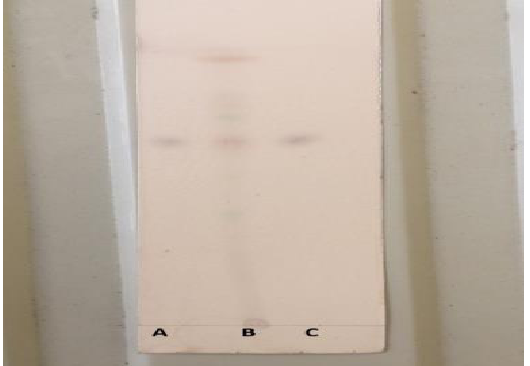
Figure 2 . Thin layer chromotography for hexane